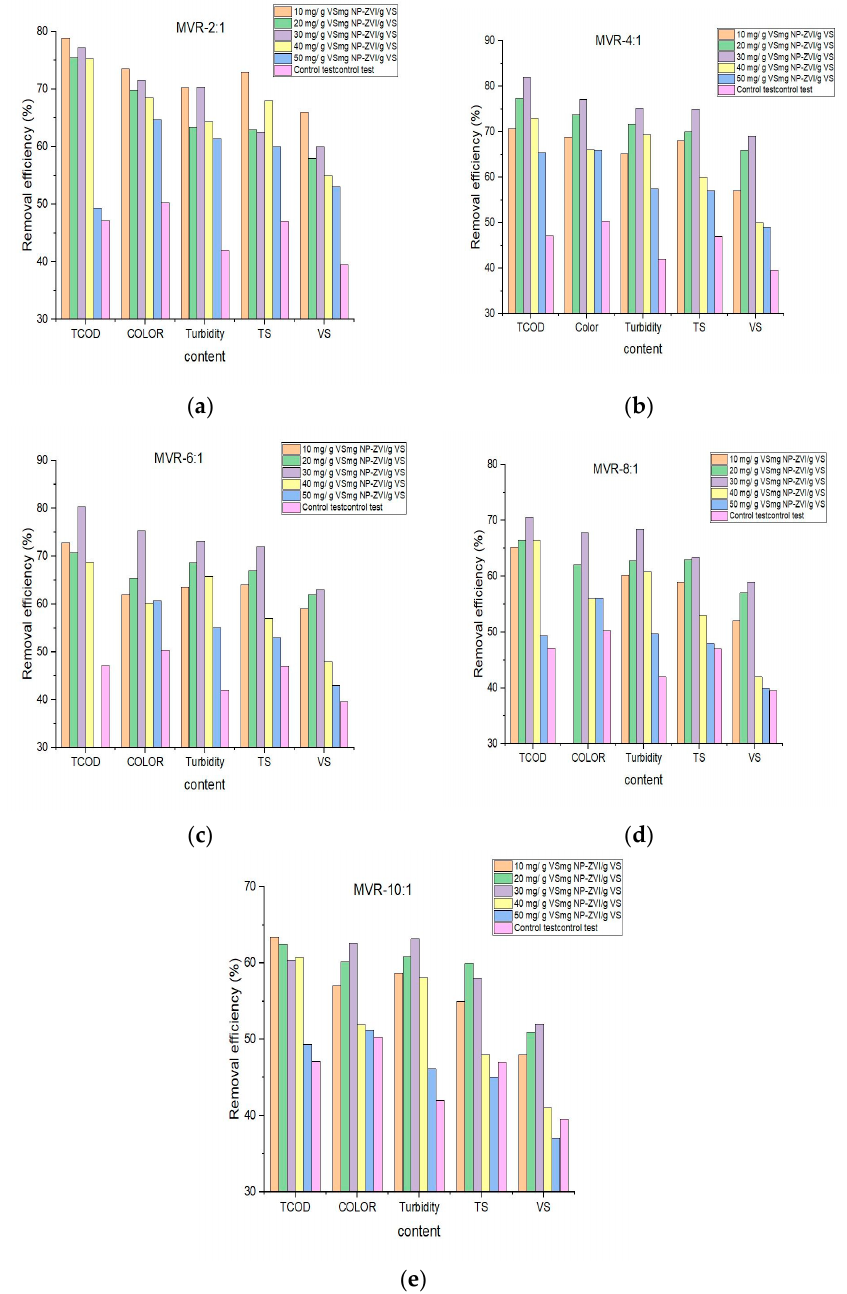
Figure 3. ( a ) Effect of NP-ZVI concentration and MVR-2:1 of NaBH 4 :FeSO 4 .7H 2 O on TS, VS, and contaminant removal efficiency; ( b ) Effect of NP-ZVI concentration and MVR -4:1 of NaBH 4 :FeSO 4 .7H 2 O on TS, VS, and contaminant removal efficiency; ( c ) Effect of NP-ZVI concentration and MVR-6:1 of NaBH 4 :FeSO 4 .7H 2 O on TS, VS, and contaminant removal efficiency; ( d ) Effect of NP-ZVI concentration and MVR-8:1 of NaBH 4 :FeSO 4 .7H 2 O on TS, VS, and contaminant removal efficiency; ( e ) Effect of NP-ZVI concentration and MVR-10:1 of NaBH 4 :FeSO 4 .7H 2 O on TS, VS, and contaminant removal